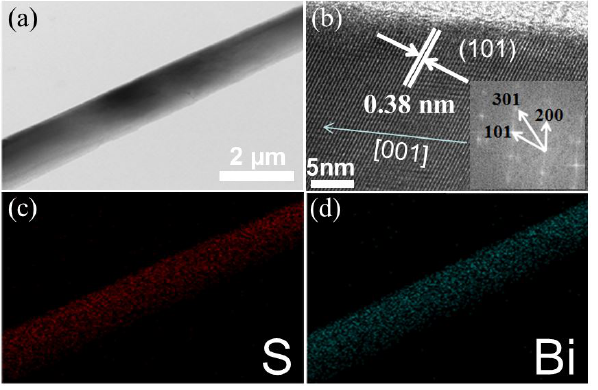
Fig. 2. (a) TEM image of an individual Bi 2 S 3 NR. (b) Corresponding HRTEM image. (c) and (d) elemental mapping of both S and Bi. Fig. 3. (a) Schematic illustration of the Bi 2 S 3 NR device. (b) I − V curves and responsivity of Bi 2 S 3 NR in dark and under 560 nm light illumination, the inset shows an SEM image of the device. (c) Pho- toresponsive characteristics of the Bi 2 S 3 NR device. (d) Summary of both dark current and photocurrent of five representative individual Bi 2 S 3 NR based device without HGNs